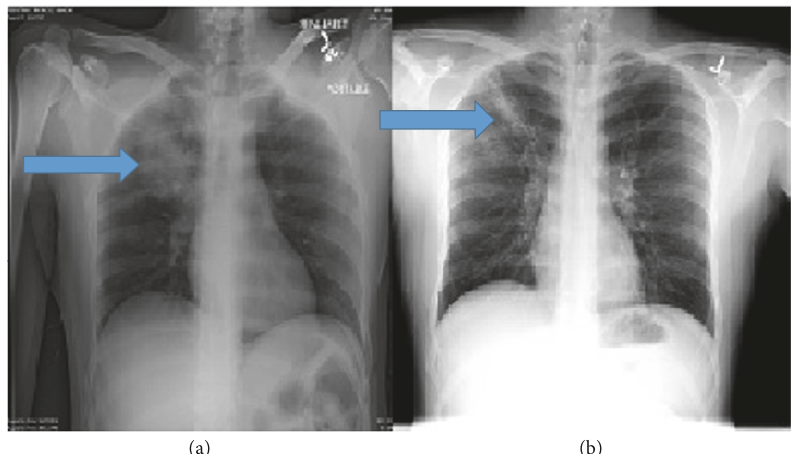
Figure 1: (a) Chest X-ray performed on admission, showing right upper lobe consolidation. (b) Chest X-ray performed at 2-month follow-up, showing right upper lobe scarring and improvement in consolidation.